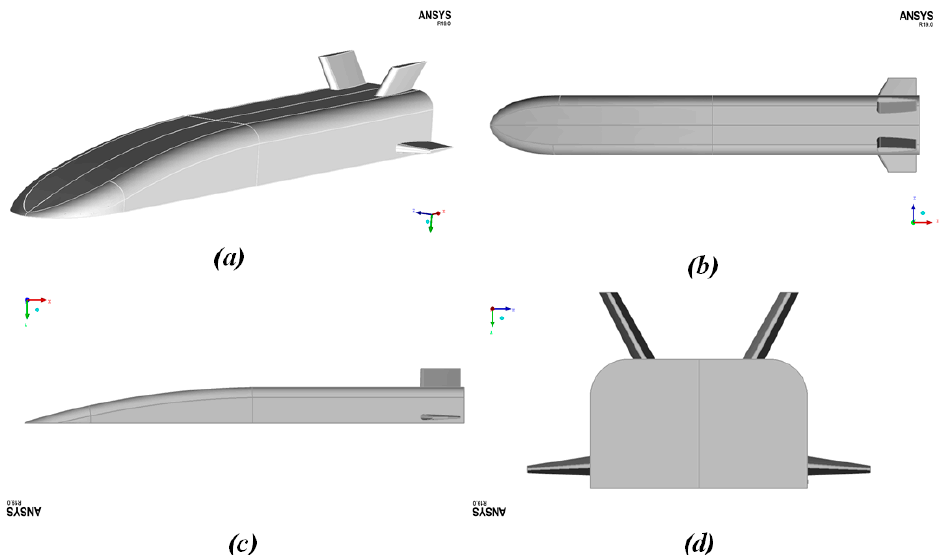
Figure 1. Three-dimensional model of X-51a cruise body: ( a ) Three-dimensional model; ( b ) The top view; ( c ) The side view; ( d ) The rear view.